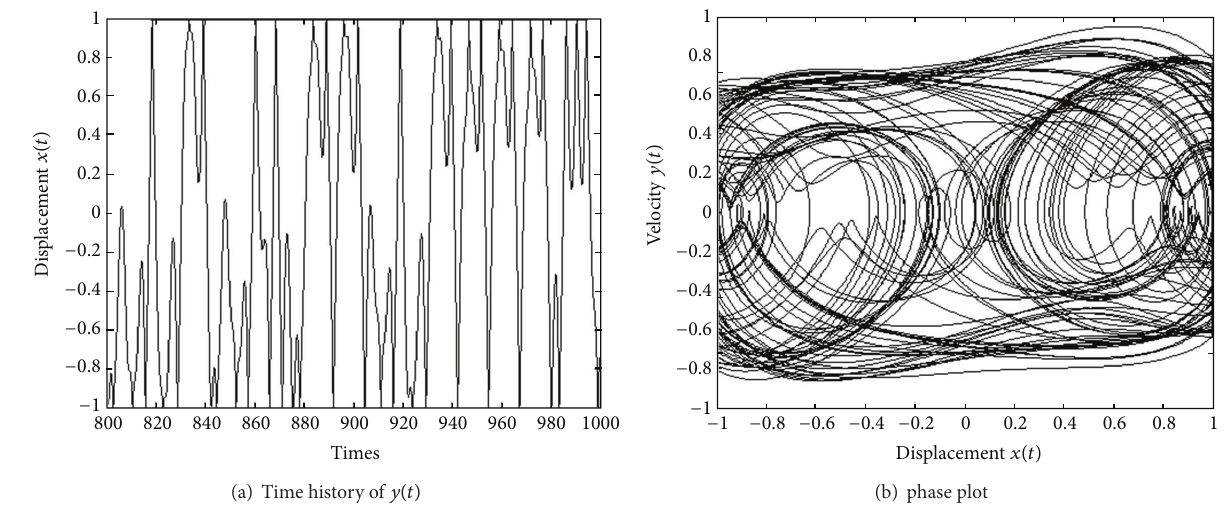
Figure 6: Numerical results of (1) ( 𝑓 1 = 5.5, 𝑓 2 = 0.05, 𝑥(0) = −0.8, ̇𝑥(0) = −2.5